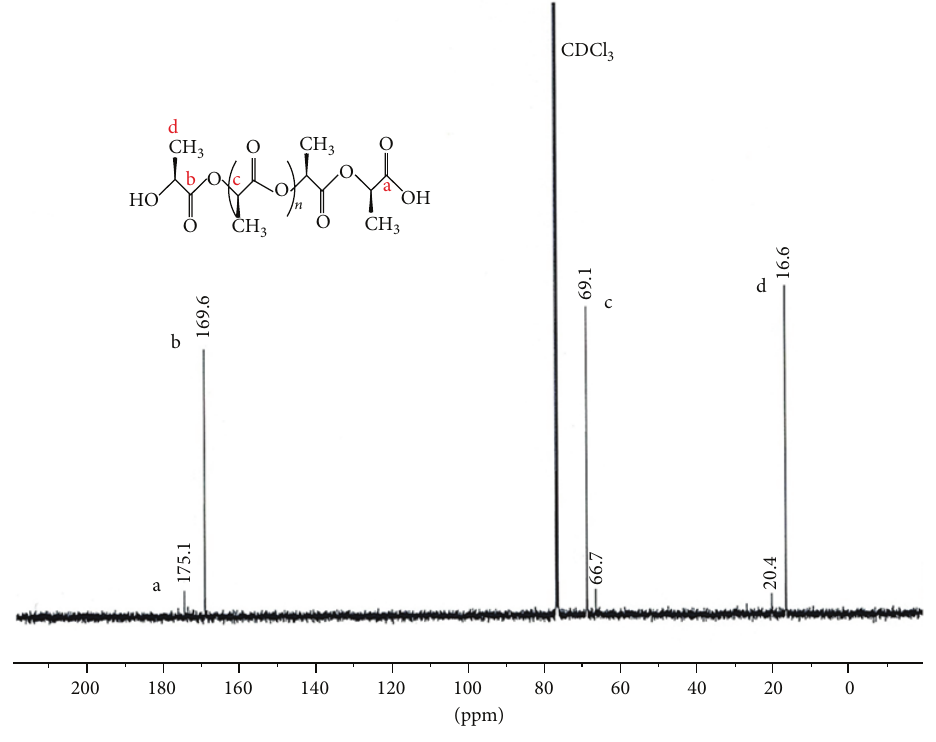
Figure 3: Spectrum 13 C-NMR of